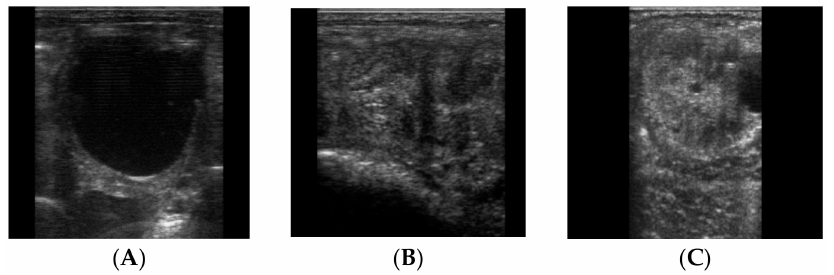
Figure 1. Ecography of the jenny’s ovary. ( A ) Estrus. Dominant follicle ( > 35 mm in diameter); ( B ) Estrus. Uterine edema, ( C ) Diestrus. Corpus luteum